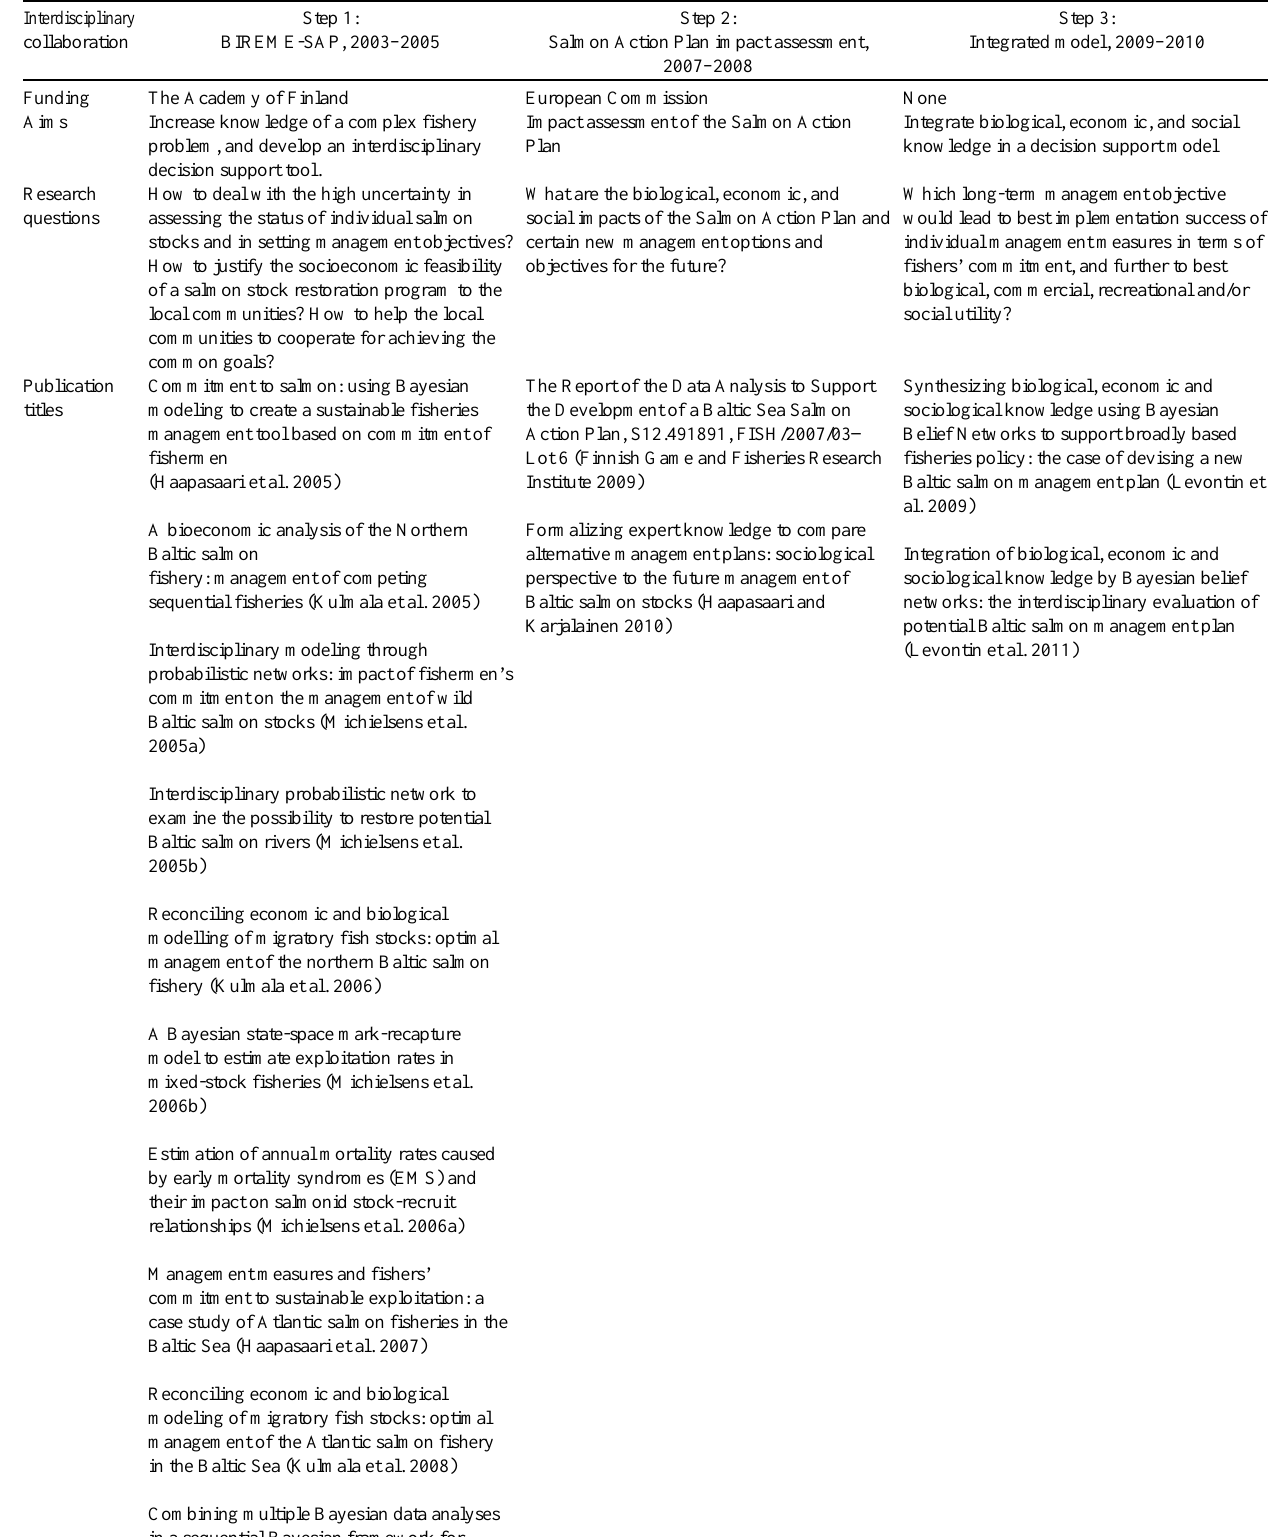
Table 2 . The three projects (Steps 1, 2, and 3) in a